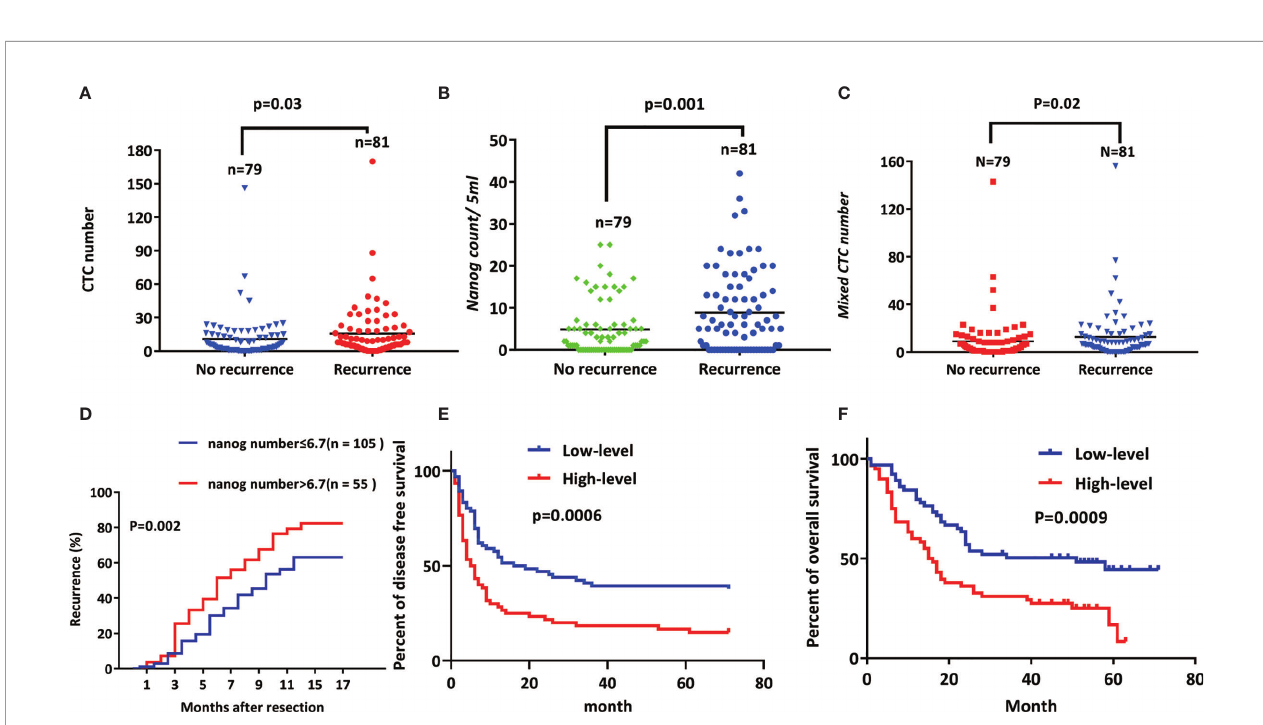
FIGURE 4 | The clinicopathological features of patients are related to the expression of Nanog (A) BCLC staging, (B) tumor size, (C) AST, (D) HBV DNA, and (E) ALT are associated with Nanog.